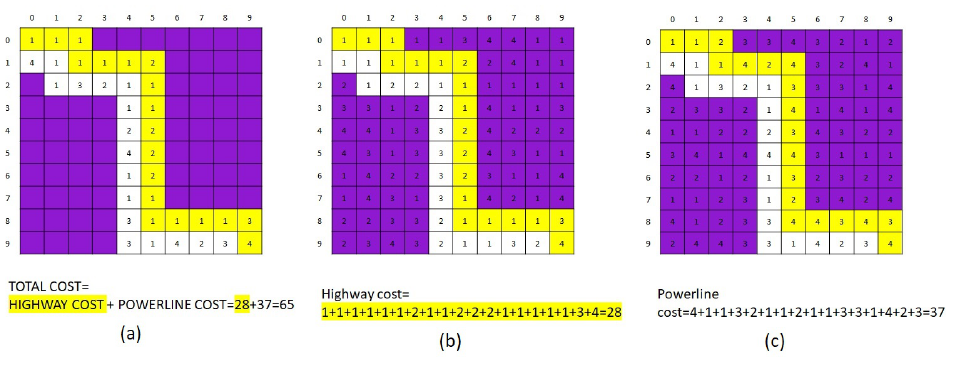
Figure 16. The same data as in Figure 15 is used in this experiment. Subfigure ( a ) is a two-mode corridor found by the MLTG method with the paths of highway and power line shown in red and green, respectively. Subfigure ( b ) The path is depicted on the cost layer of highway and the calculated cost of highway is 28. Subfigure ( c ) The path is depicted on the cost layer of the powerline and the calculated cost of powerline is 37. The total cost is a summation of these two costs which is equal to 65, as shown in Subfigure ( a